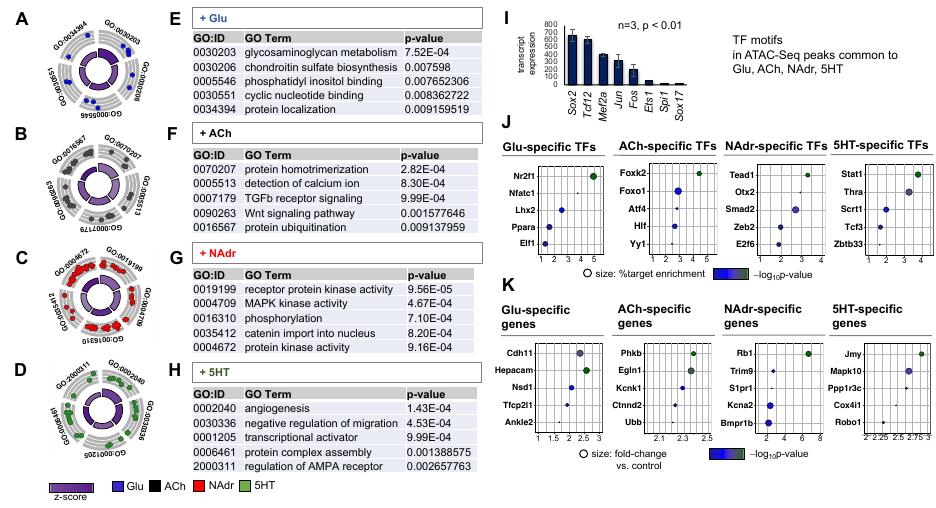
Figure 5. Unique chromatin accessibility signatures are exhibited by mES_astrocytes in response to different neuroactive chemicals. ( A–H ) GO circle plot and tables showing top GO terms found in DEGs ( p < 0.01) associated with each chemical: ( A , E ) Glu, ( B , F ) ACh, ( C , G ) NAdr, and ( D , H ) 5HT. Note that NAdr induces the most differentially enriched chromatin-accessible sites across the panel of chemicals. ( I ) Significant transcription factor motifs ( p < 0.01) enriched in all differential ATAC-Seq peaks from Glu, ACh, NAdr, and 5HT. Transcription factors are shown based on transcript expression levels in in vivo astrocytes. ( J , K ) Top five ( J ) transcription factor motifs that are enriched at chromatin-accessible peaks and ( K ) genes with open chromatin signatures that are induced unique to each neurochemical in comparison to controls ( n = 3, p < 0.05) and filtered based on transcript expression levels of in vivo astrocytes. Detailed lists of these genes are given in Table